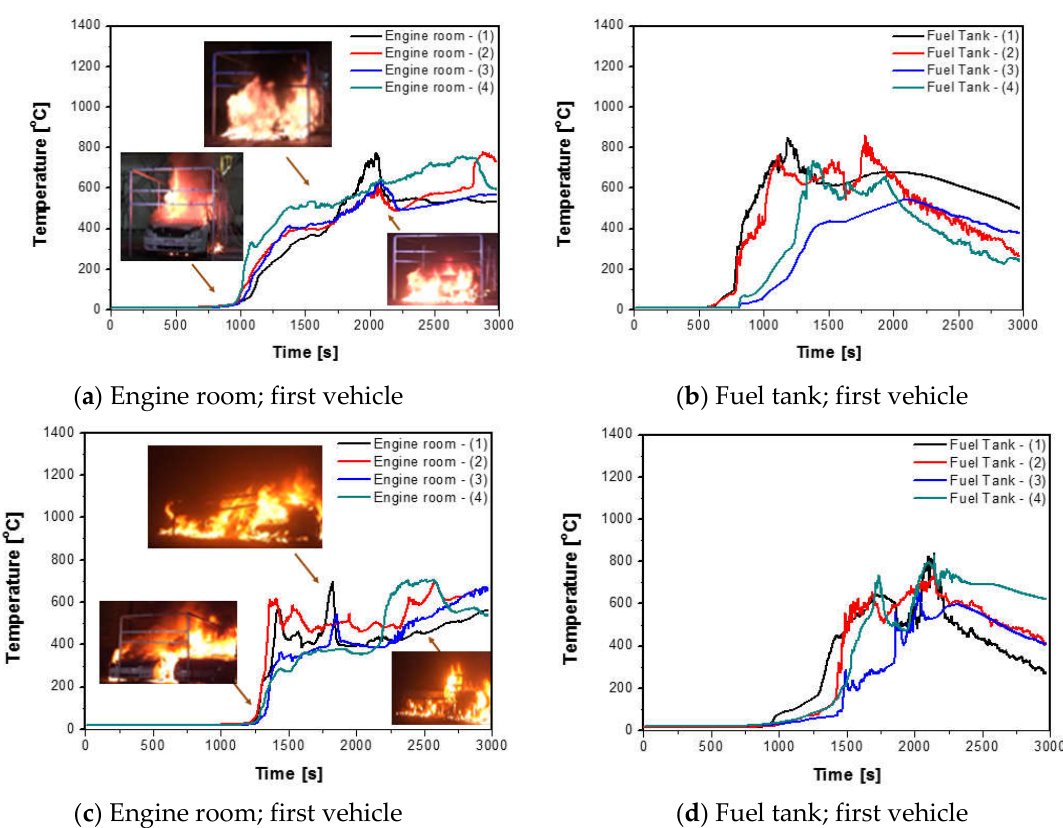
Figure 9. Temperature distribution in the engine room and fuel tank for one and two vehicles: ( a ) Temperature of engine room in first vehicle in the one-vehicle experiment, ( b ) temperature of fuel tank in first vehicle in the one-vehicle experiment, ( c ) temperature of engine room in first vehicle in the two-vehicle experiment, and ( d ) temperature of fuel tank in first vehicle in the two-vehicle